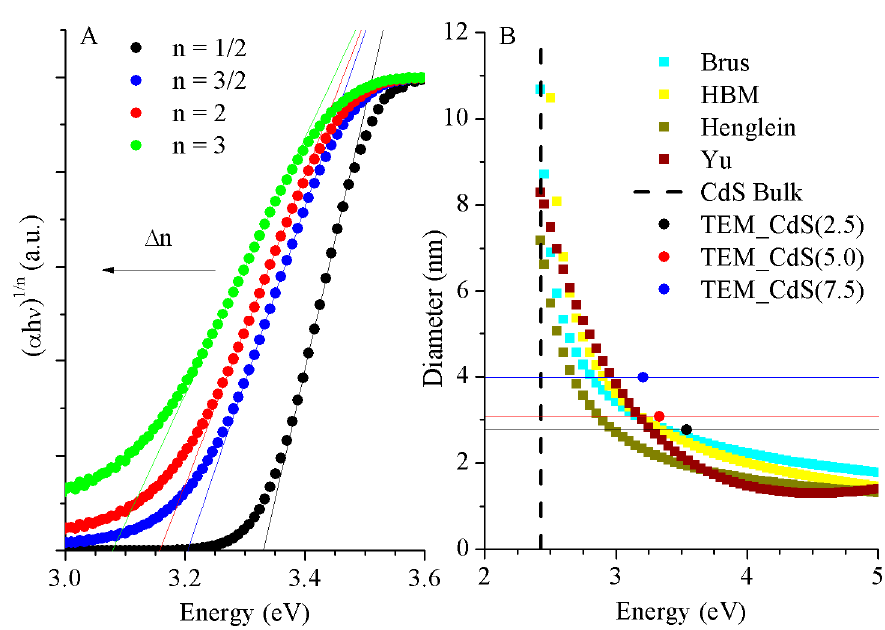
Figure 5. Graphs of Tauc relation with different n values for CdS nanoparticles ( A ), where n depends on the nature of interband electronic transition, varying between n = 1/2, 3/2, 2, and 3. Different simulation ( B ) of nanoparticles’ (NPs’) sizes estimated with each model for CdS NPs as a function of bandgap energy. Horizontal lines set the average diameter of the nanoparticles calculated by the TEM images: CdS(2.5) (black line), CdS(5.0) (red line), and CdS(7.5) (blue line). The corresponding circle is located according to the optical gap calculated from absorbance spectra.